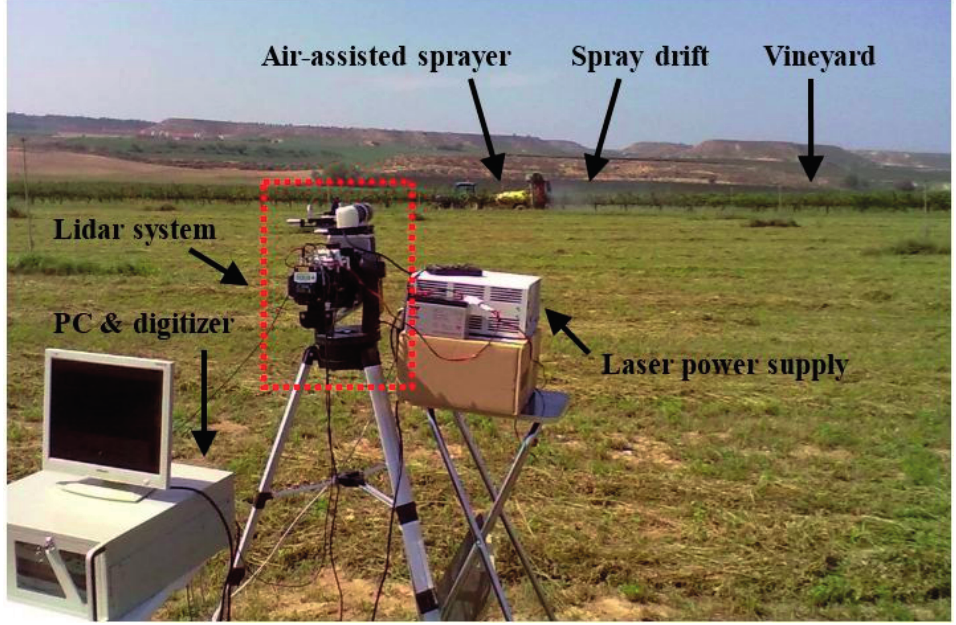
Figure 11. Lidar system deployed in the field during a spray drift measurement.